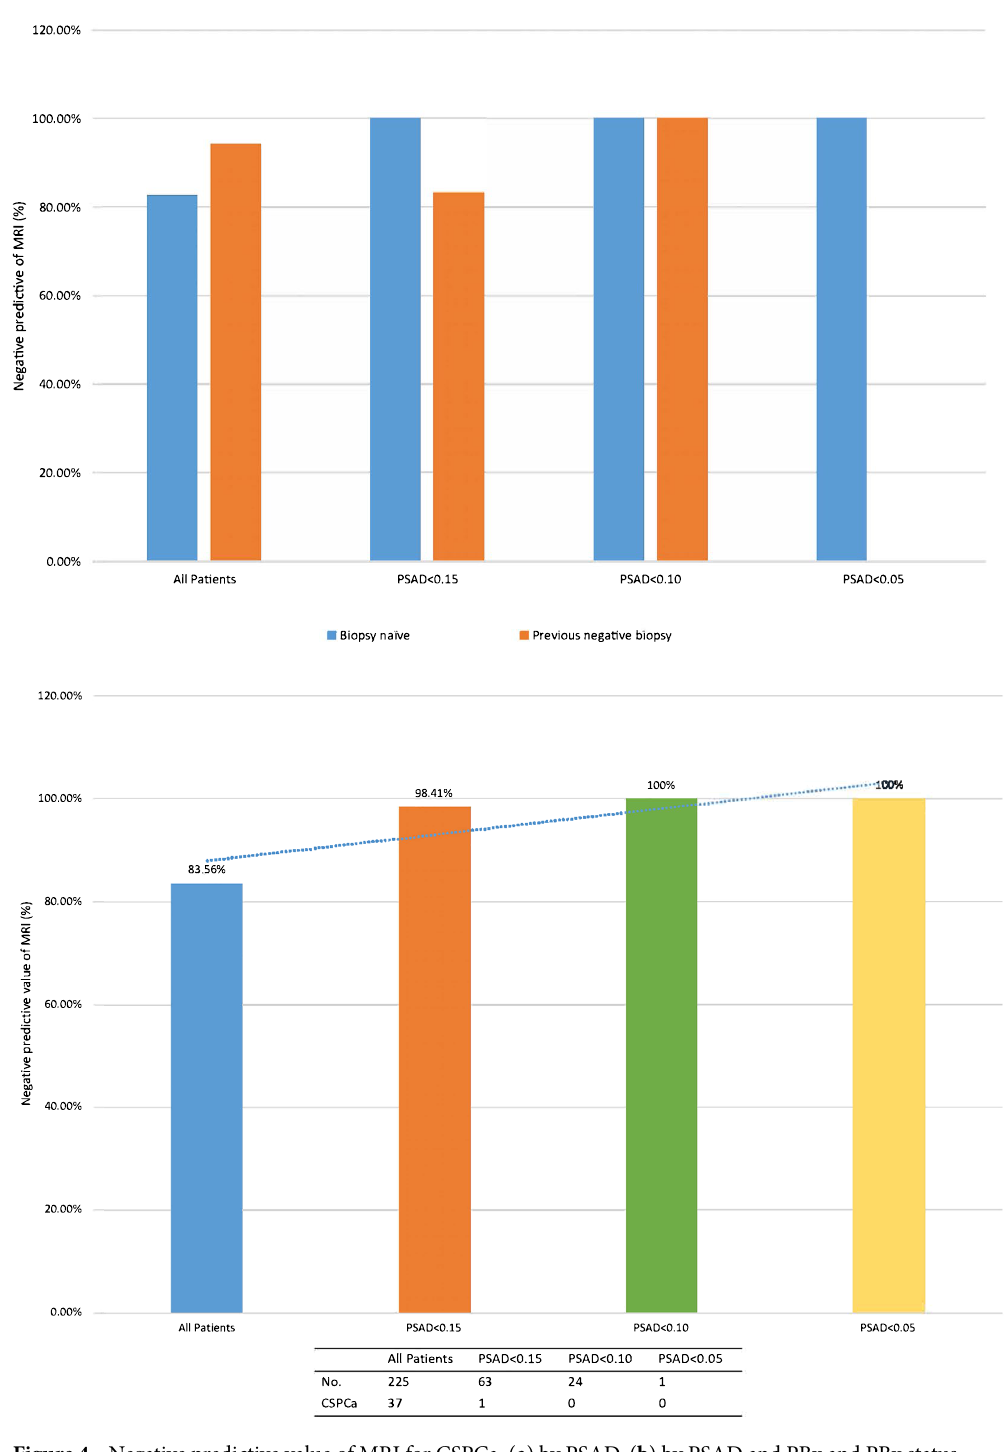
Figure 4. Negative predictive value of MRI for CSPCa. ( a ) by PSAD. ( b ) by PSAD and PBx and PBx